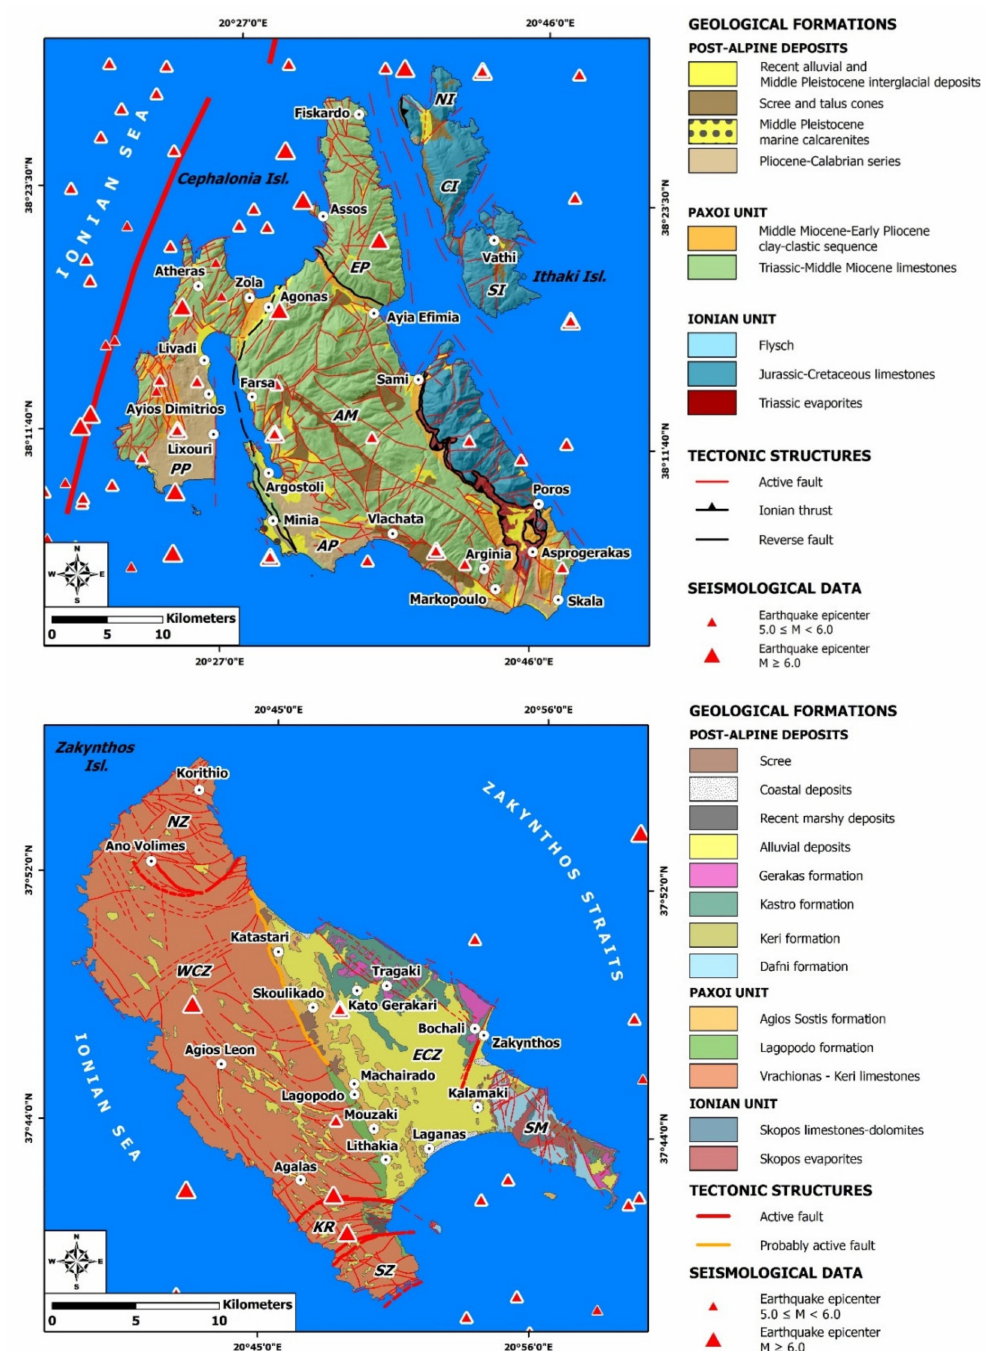
Figure 2. Neotectonic maps of Cephalonia, Ithaki and Zakynthos Islands based on Lekkas et al. [4,5,36] along with their fault blocks. Cephalonia: fault blocks of Erissos peninsula (EP), Paliki peninsula (PP), Aenos Mt (AM) and Argostoli peninsula (AP). Ithaki: fault blocks of northern, central and southern Ithaki (NI, MI and SI respectively). Zakynthos: fault blocks of northern Zakynthos (NZ), western part of central Zakynthos (WCZ), eastern part of central Zakynthos (ECZ), Keri (KR), southern Zakynthos (SZ) and Skopos Mt